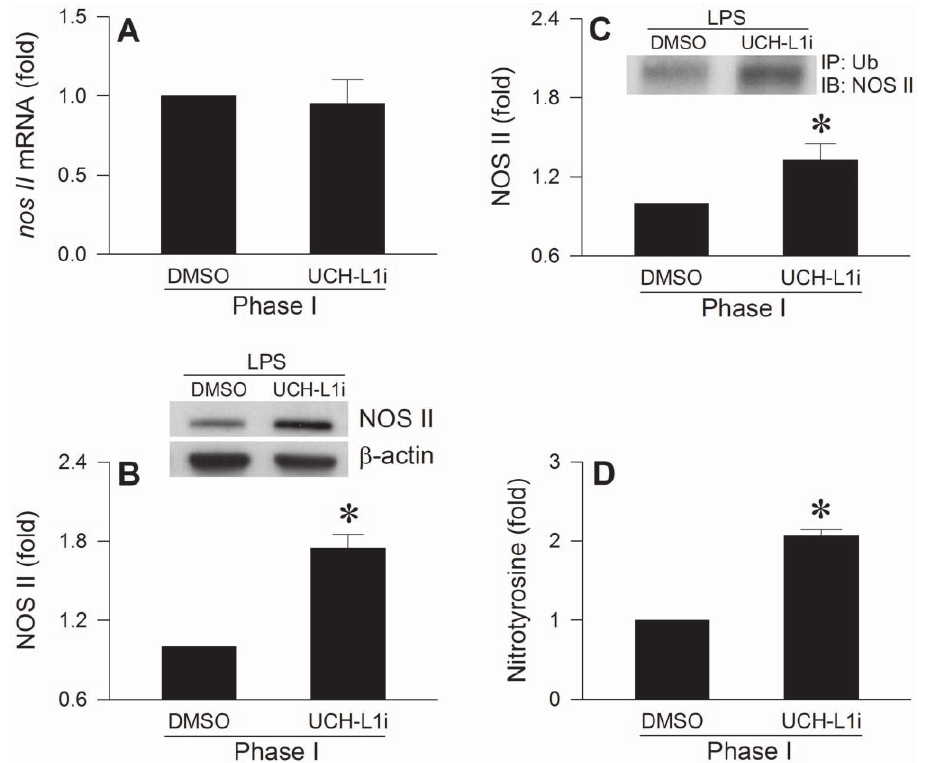
Figure 7. De-ubiquitination is crucially involved in degradation of NOS II at RVLM. Illustrative gels or summary of fold changes against sham-controls in nos II mRNA determined by real-time PCR (A), NOS II protein detected by Western blot analysis (B), immunoblot analysis of NOS II immunoprecipitated by an anti-ubiquitin (Ub) antiserum (C) or nitotyrosine determined by ELISA (D) in ventrolateral medulla of rats that received pretreatment by microinjection bilaterally into RVLM of UCH-L1 inhibitor (UCH-L1i) or DMSO, during Phase I experimental endotoxemia induced by IV administration (at arrows) of LPS (15 mg kg 2 1 ). Values are mean 6 SEM of triplicate (mRNA) or duplicate (protein) analyses on individual samples obtained from 5–6 animals per experimental group. * P , 0.05 versus DMSO-control group in the Scheffe´ multiple-range